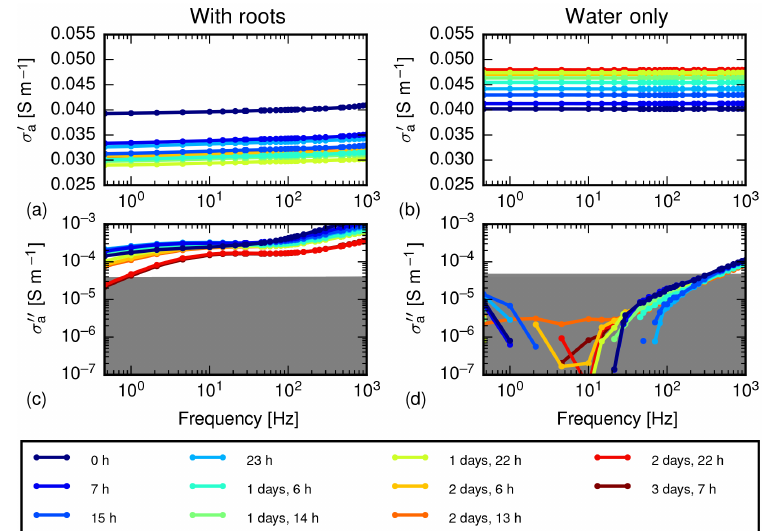
Figure 5. Temporal evolution of raw data spectra, plotted as real (a, b) and imaginary (c, d) components of apparent complex conductivity (Eq. 3) for two example measurement configurations: (a, c) current injection between electrodes 3 and 4, and voltage measurement between electrodes 5 and 6 (quadrupole located directly above the root system, i.e., response “with roots”); (b, d) current injection between electrodes 34 and 35 and voltage measurement between electrodes 36 and 37 (quadrupole located in an area relatively far away from the root system, i.e., “water-only” response). For electrode numbering, see Fig. 1b. Blue indicates early measurements, while later ones are shown in red. Values of σ (cid:48)(cid:48) that lie below the measurement accuracy of the system (1mrad phase shift at 1kHz for water; see Zimmermann et al., 2008) are indicated by gray